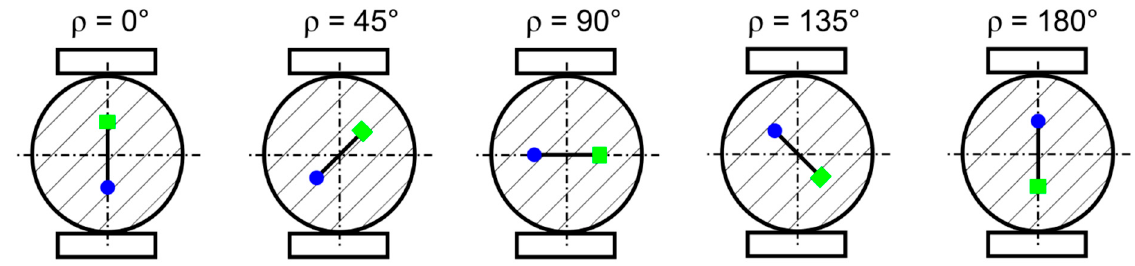
Figure 3. Schematic illustration of the changing orientation of the crack during rolling and the angle ρ that describes the rolling position.